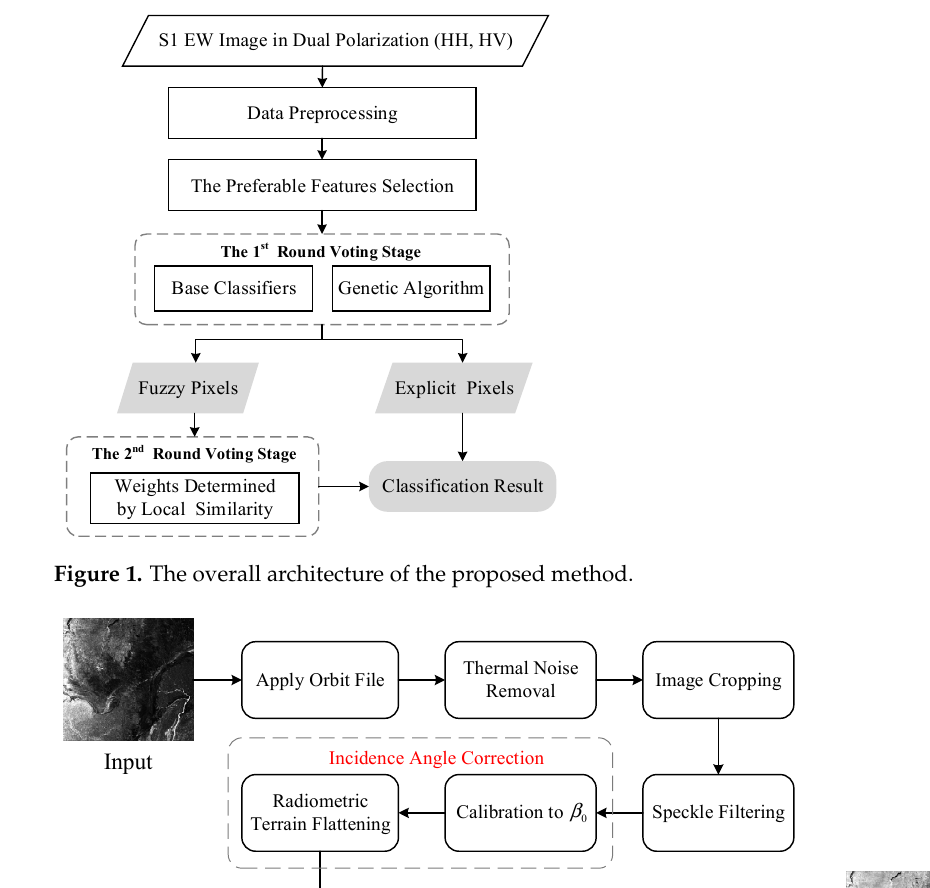
Figure 1. The overall architecture of the proposed method.